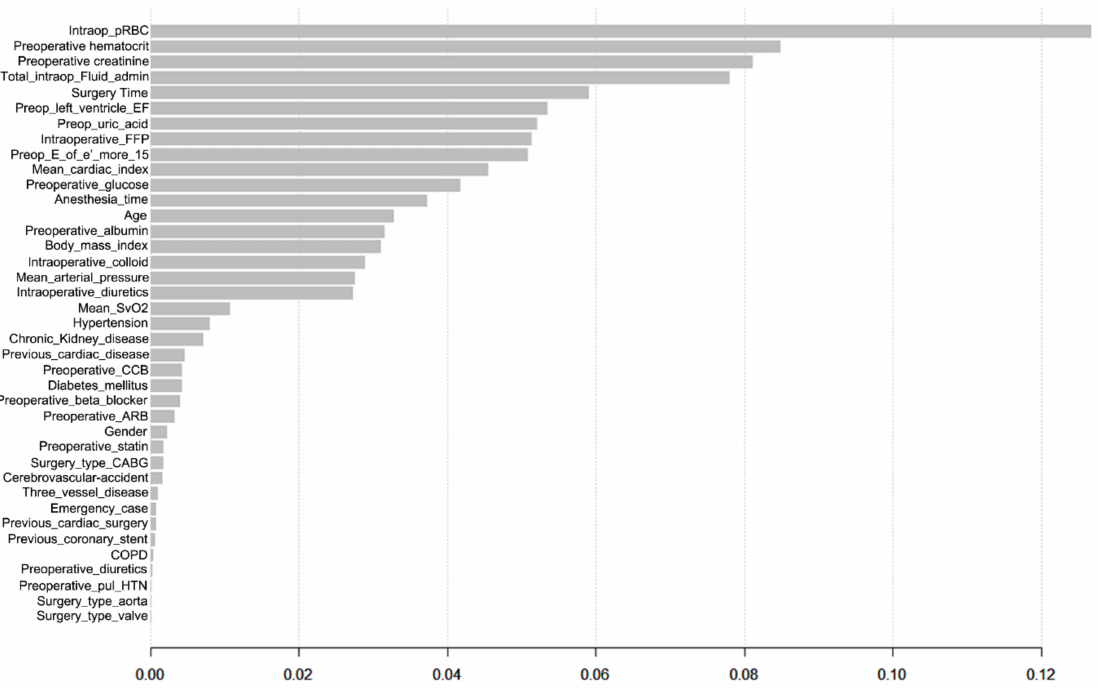
Figure 3. Importance matrix plot of the gradient boosting machine. This figure shows the importance of each covariates in the final model. ARB = angiotensin receptor blocker, BMI = body-mass index, CABG = coronary artery bypass graft, CCB = calcium channel blocker, CKD = chronic kidney disease, Cr = creatinine, CVA = history of cerebrovascular accident, EF = ejection fraction, E_or_e_prime = preoperative ratio of early transmitral flow velocity to early diastolic velocity of the mitral annulus, FFP = fresh frozen plasma, hct = hematocrit, HTN = hypertension, intraop = intraoperative, mean SvO2 = intraoperative mean mixed venous oxygen saturation, three_VD = three vessel coronary disease, preop = preoperative, pRBC = packed red blood